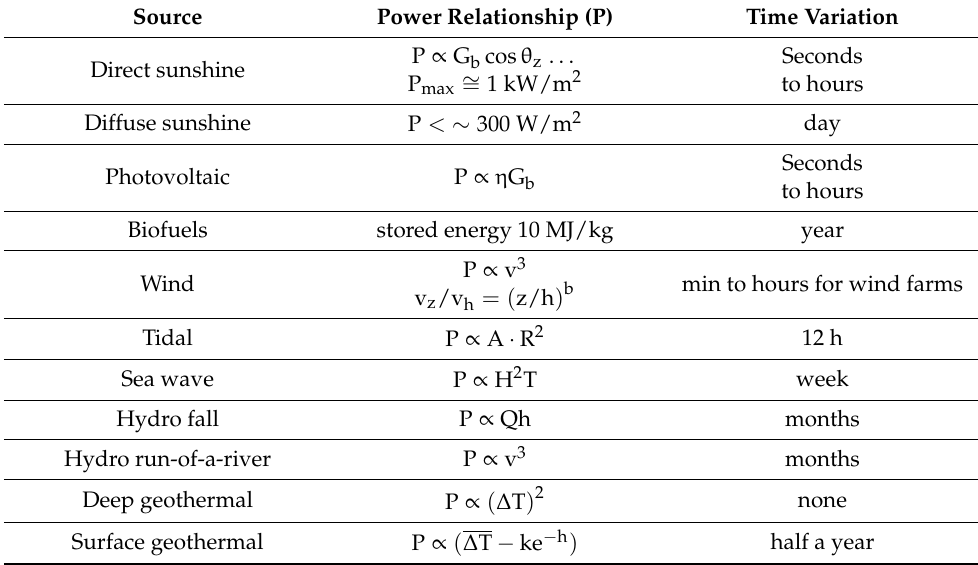
Table 2. Renewables’ intensity and